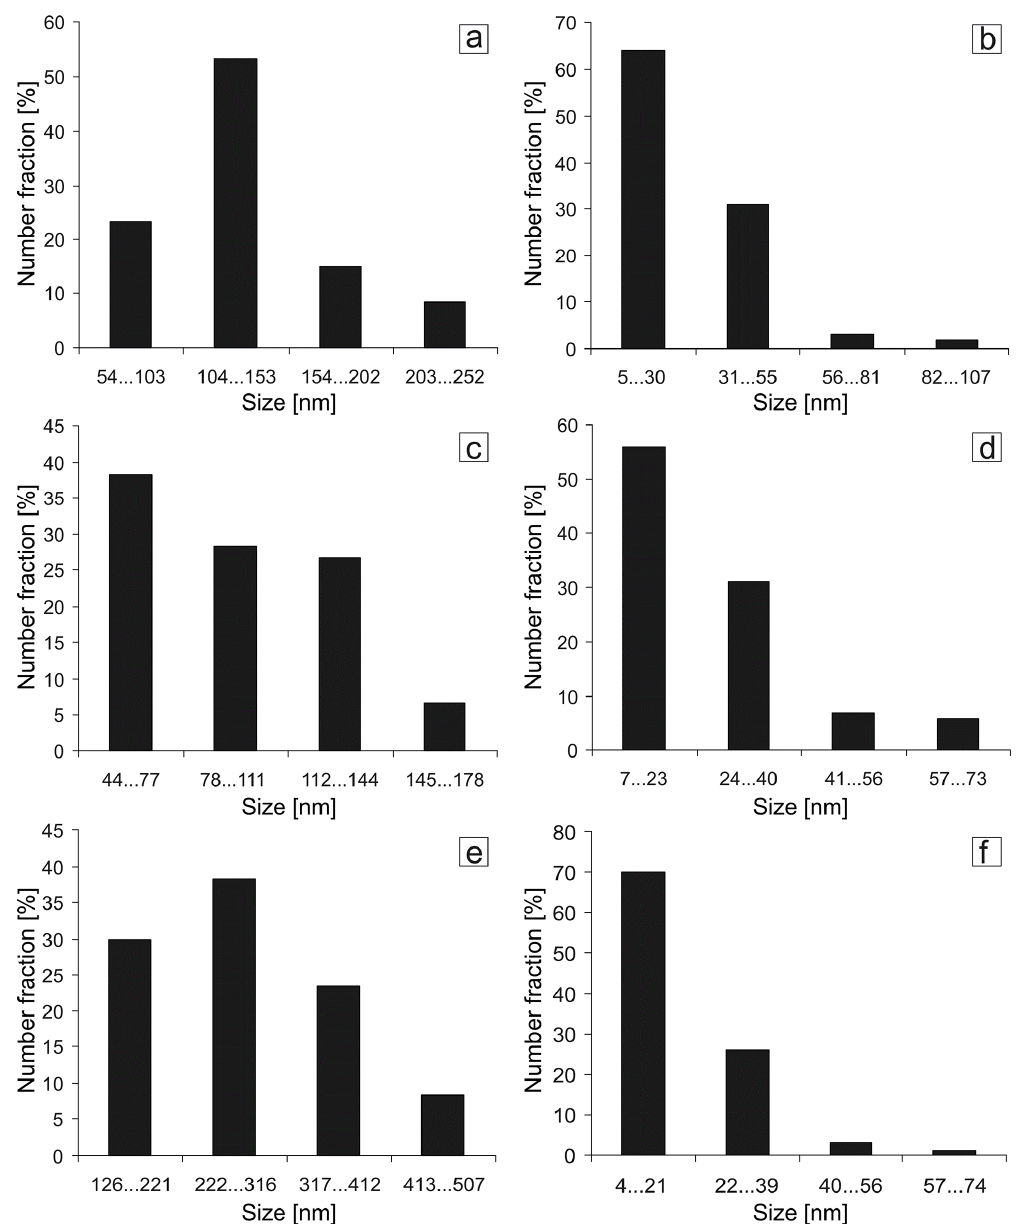
Figure 5. Histograms of size distribution of crystallites ( a , c , e ) and particles ( b , d , f ) in the HPT-processed aluminum alloys: ( a , b ) Al–10% La; ( c , d ) Al–9% Ce; ( e , f ) Al–7% Ni.